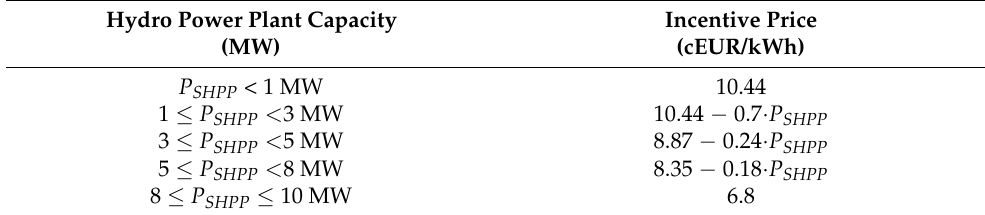
Table 1. Electricity prices depending on the capacity of the power plant